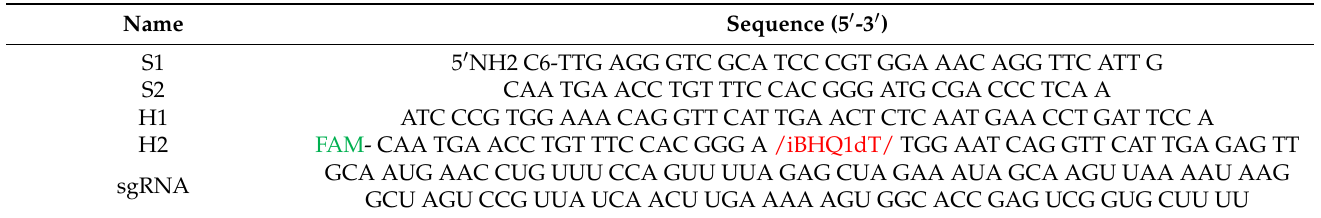
Table 1. DNAs in this